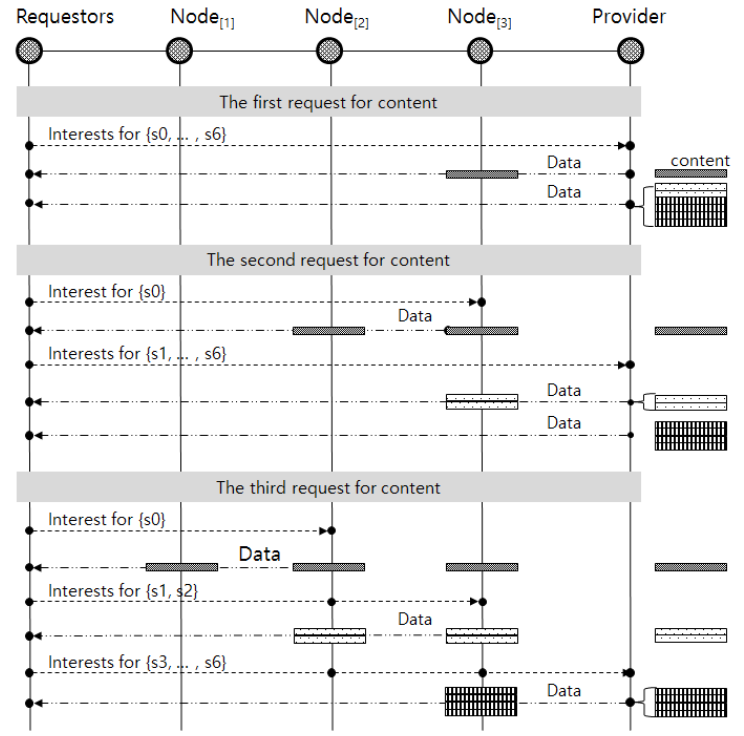
Figure 2. WAVE Procedure.